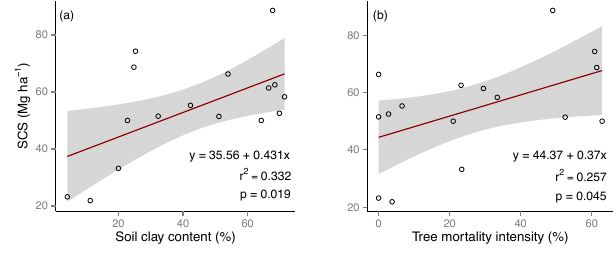
Figure 3. Soil carbon stock (SCS) as a linear function of (a) clay content (b) and tree mortality intensity (%) at 0–30cm depth